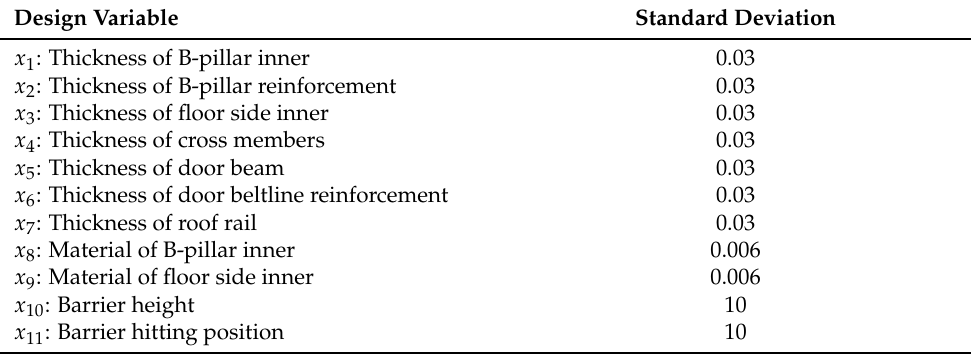
Table 5. Details of design variables and their standard deviation values.